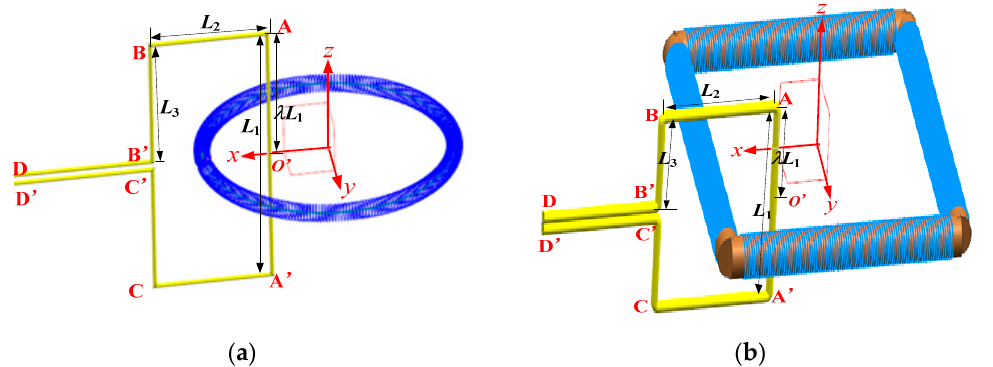
Figure 12. The D-shaped primary conductor vertically through Rogowski coils ( 𝜆 = 0.5 ). ( a ) The Rogowski coil of the oval skeleton; ( b ) the Rogowski coil with rectangular skeleton.